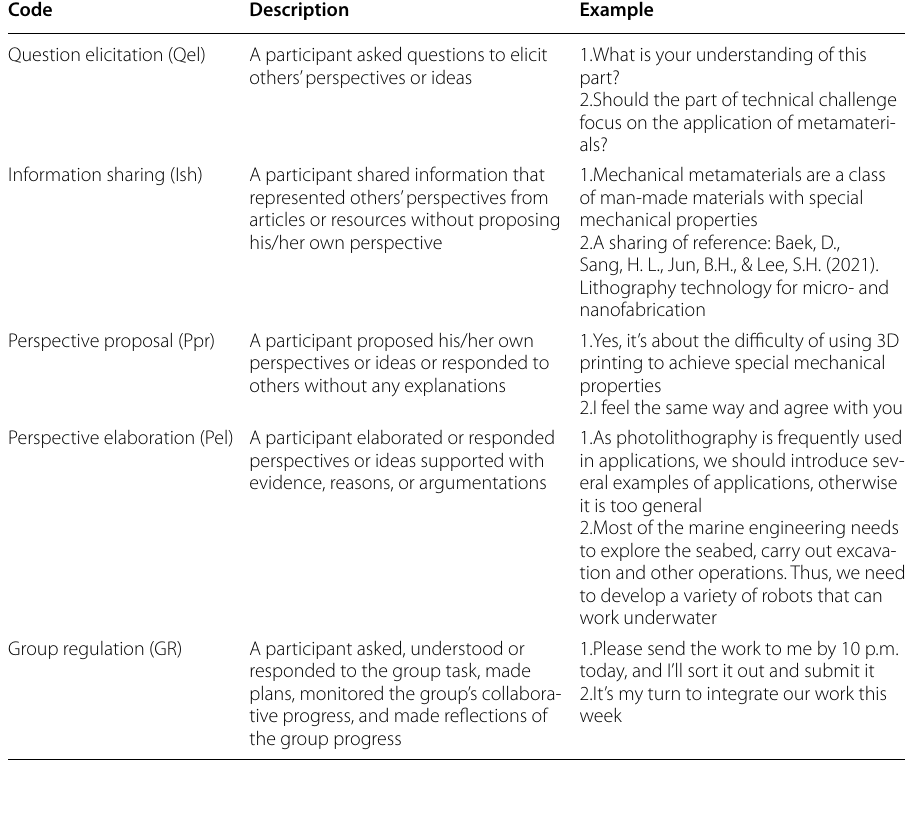
Table 2 Content analysis framework of the discussion content